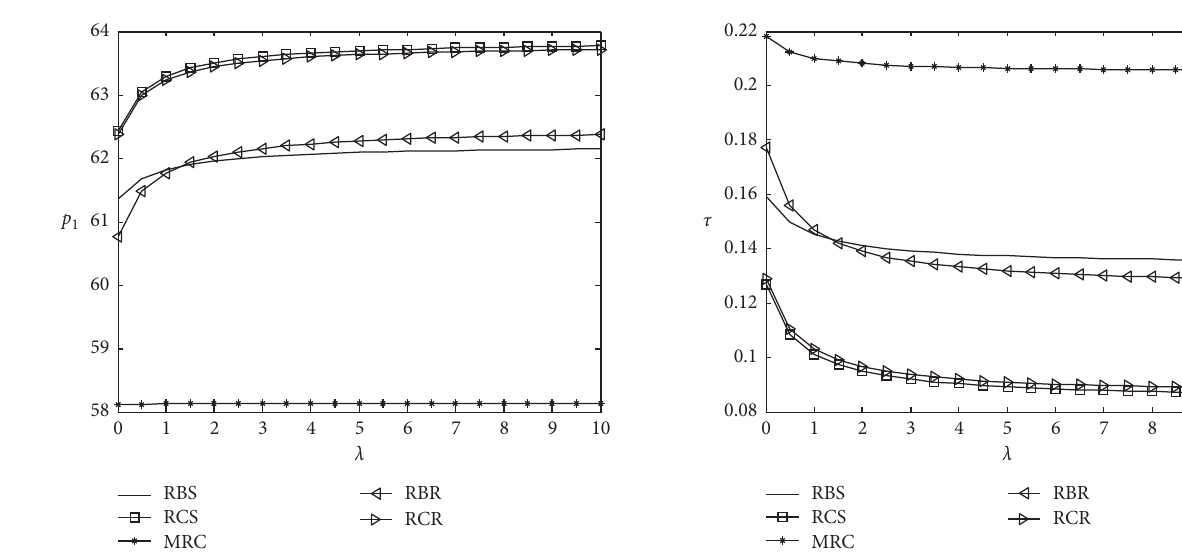
Figure 4: Effect of fairness preference on recycling rate.